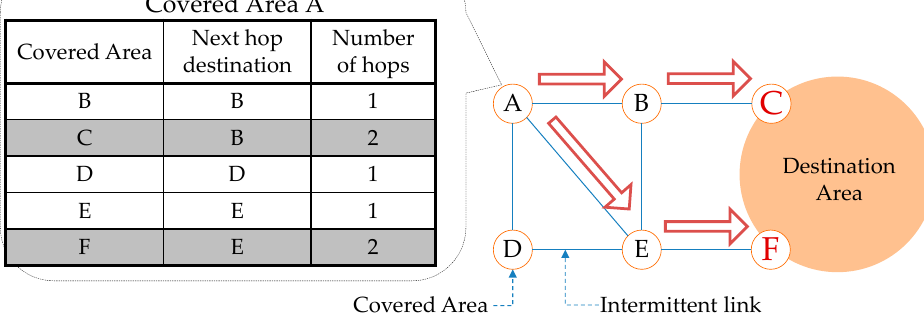
Figure 7. Routing example.